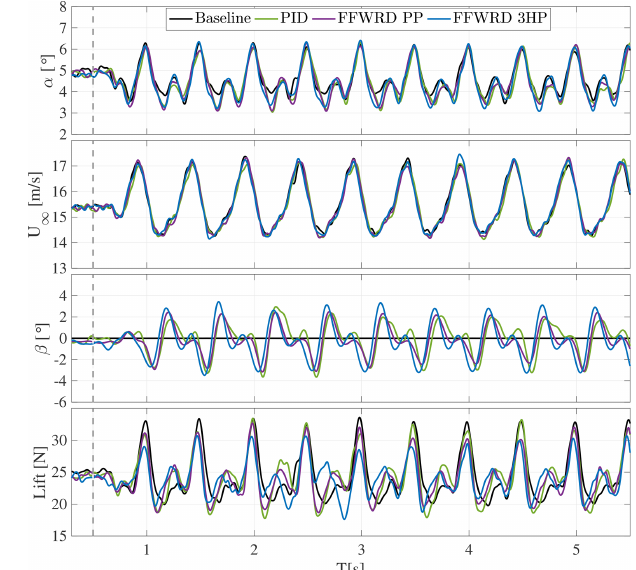
Figure D2. Time series of angle of attack and velocity variation, flap motion, and resulting lift amplitude at a reduced frequency of k = 0 . 128.